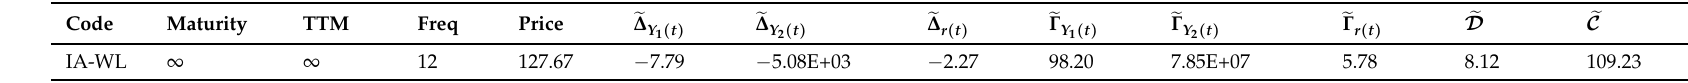
Table 6. These are details of the life annuity with monthly payments. The deltas with respect to the mortality risk factors are negative. Increases in these factors produce lower survival probabilities used for the discount factors and hence lower annuity values. The interest rate delta is also negative. Increases in the short rate produce lower zero coupon bond prices and hence lower annuity values. For a 65 year old, the Fisher-Weil duration is 8.12 years. Interest rate sensitivity for the stochastic interest rate model is lower than the Fisher-Weil duration. The delta for the mortality risk factor Y 1 ( t ) is of a similar magnitude as the duration, with opposite sign. Y 1 ( t ) reflects the level of mortality, whereas Y 2 ( t ) captures the impact of age.